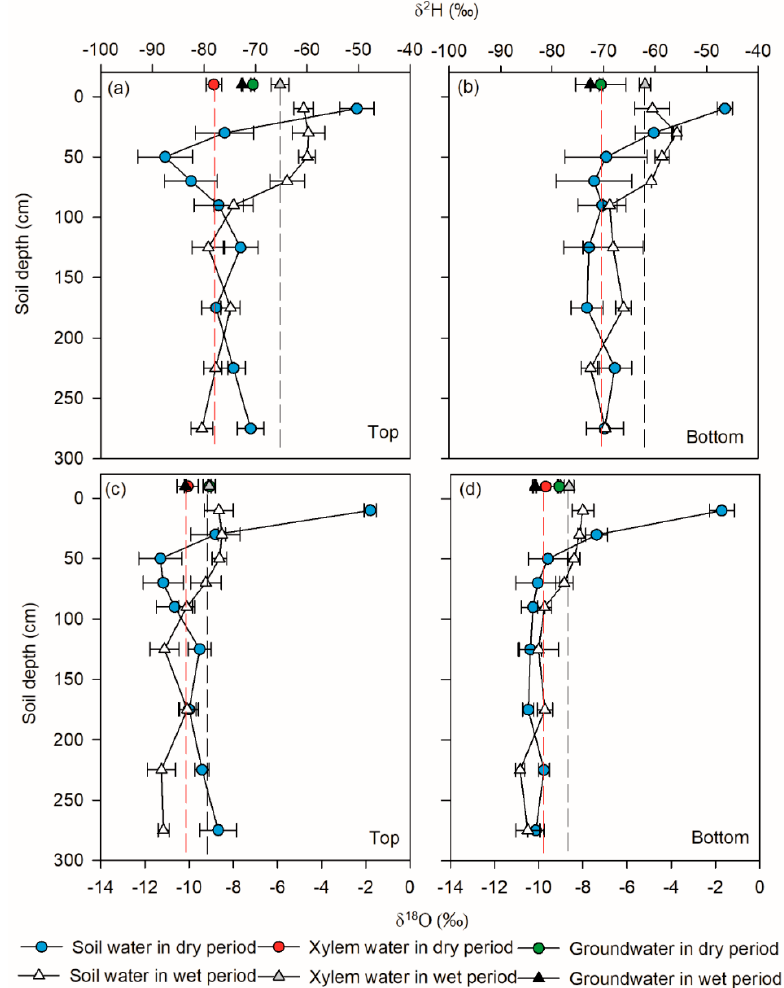
Figure 4. Average δ 2 H and δ 18 O isotopic profile of soil water, twig water, and groundwater during the dry and wet periods for Mongolian pine trees growing on the top ( a,c ) and bottom ( b , d ) of the sand dunes. Horizontal crossed bar represents ± 1 SE ( n =